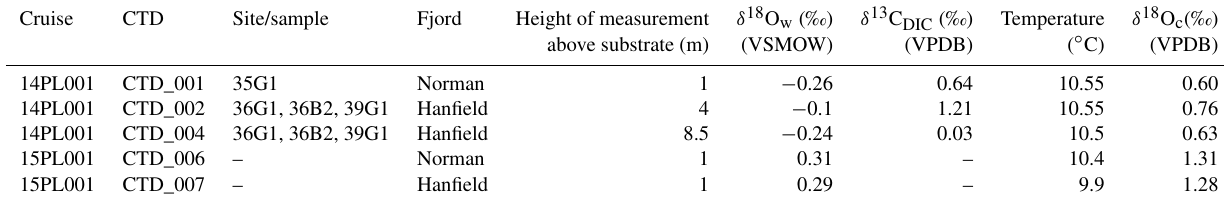
Table 2. Locations of surface sediment samples and accompanying bottom water oxygen ( δ 18 O w ) and carbon ( δ 13 C DIC ) stable isotope measurements. Expected oxygen isotopic composition of calcite precipitated in equilibrium with δ 18 O w ( δ 18 O foram ) for a given temperature was calculated using the equation from Marchitto et al. (2014) ( δ 18 O foram − δ 18 O w (VSMOW) + 0.27) = − 0 . 225 T + 3 .